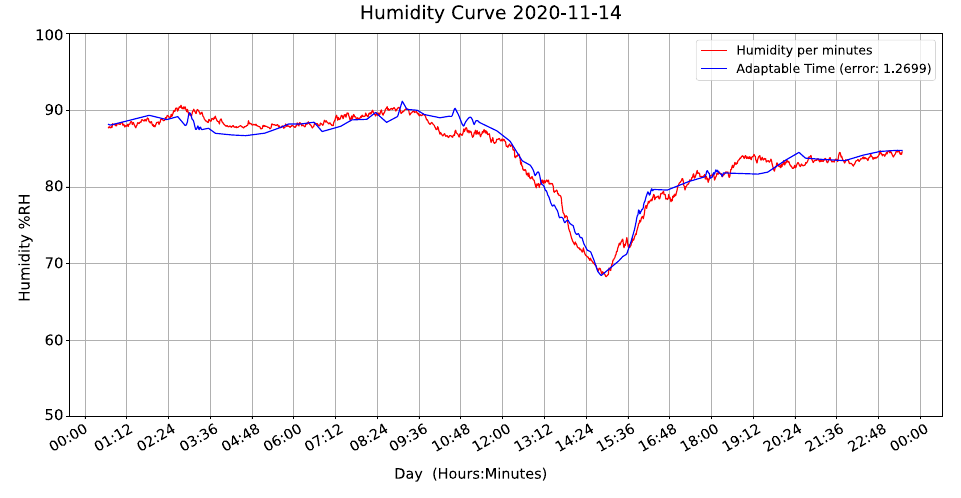
Figure 21. Humidity